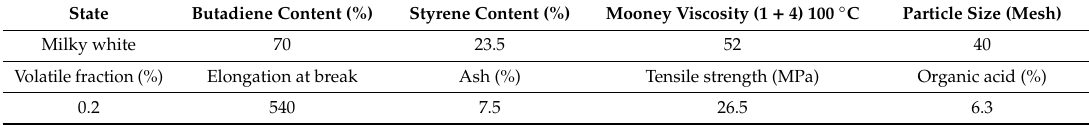
Table 3. Properties of powder Styrene-Butadiene-Rubber (SBR).